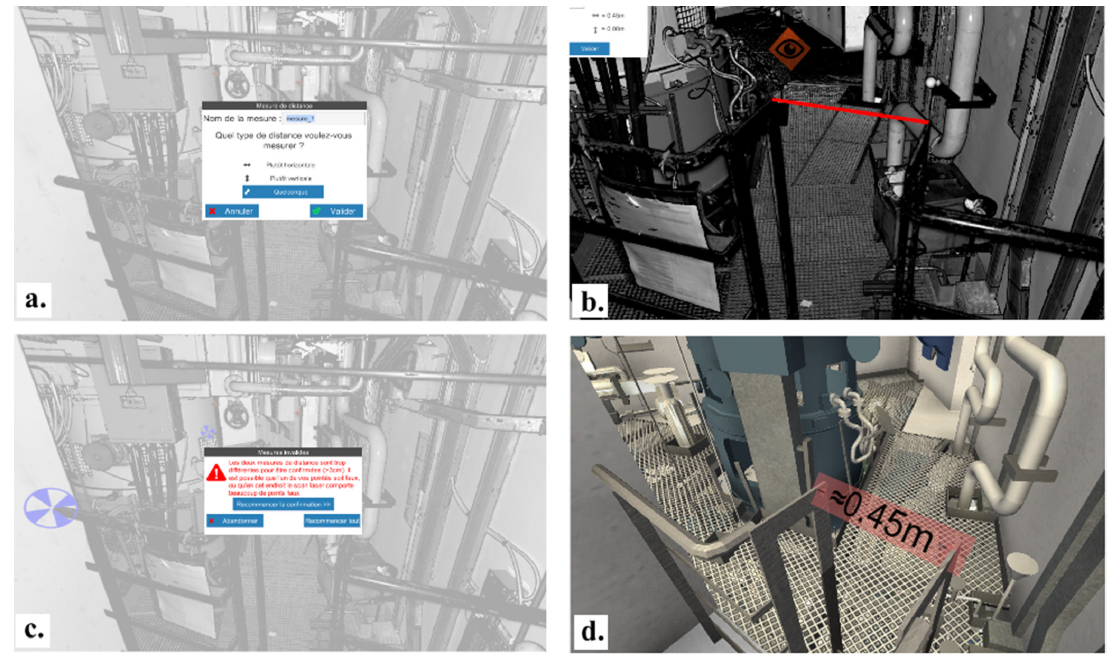
Figure 16. A procedure for improving the quality of distance measurement in laser scans. The user must ( a ) choose between measurement types and ( b ) control his/her own measurement by a double picking; then ( c ) check the result in “bubble view” and finally ( d ) in the 3D model .